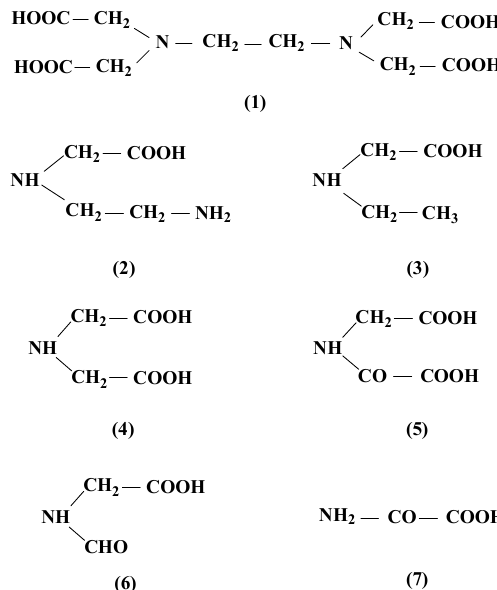
Figure 7. EDTA and electrochemical oxidation intermediates with Pt/ACF electrode.